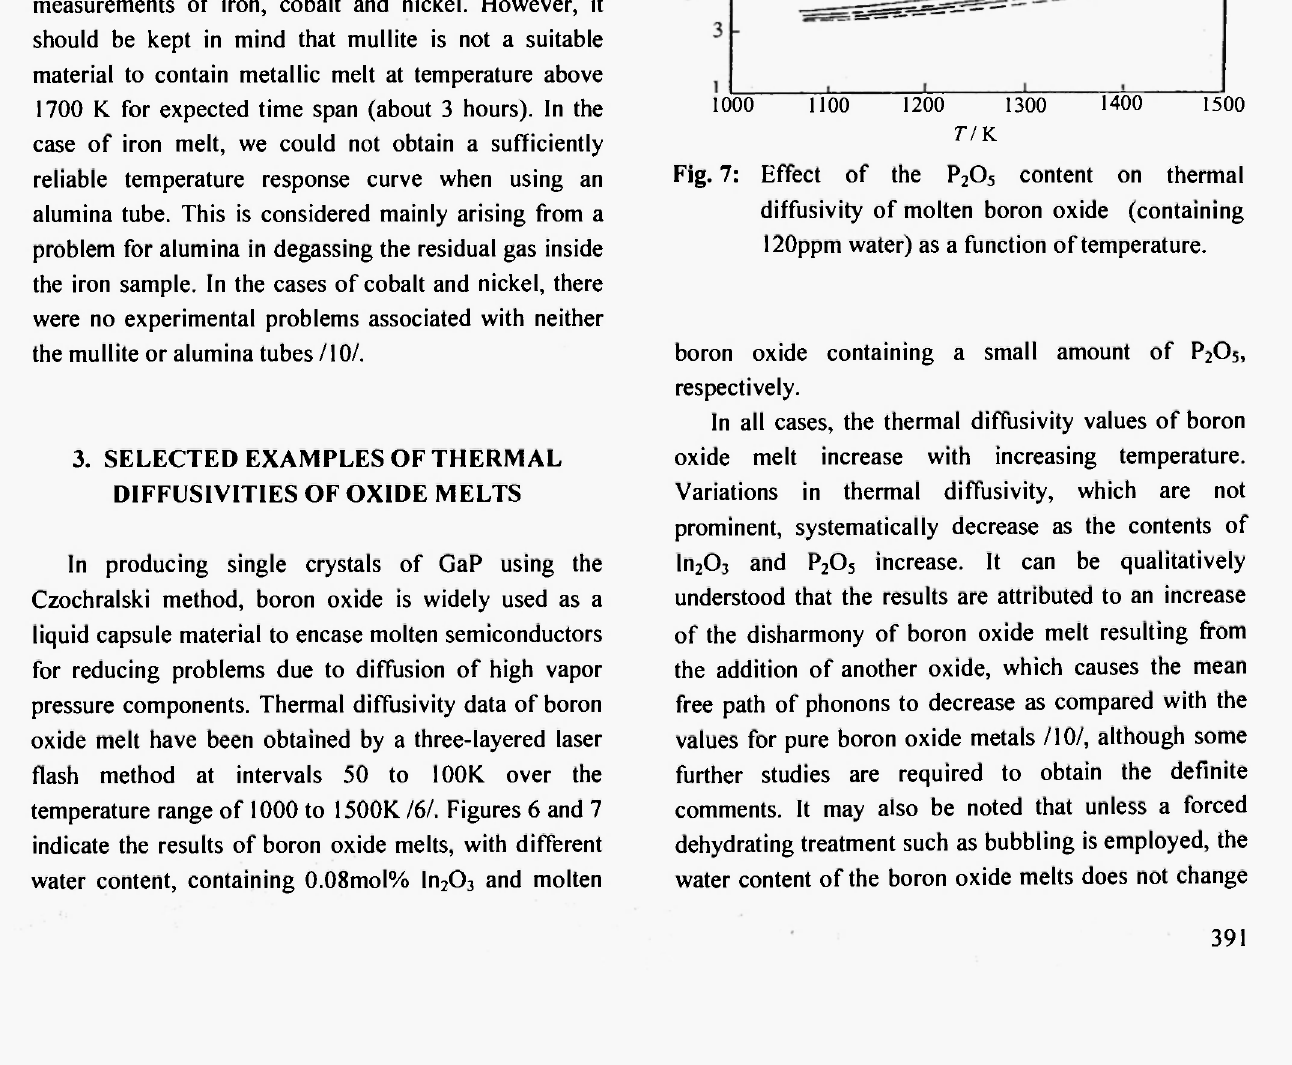
Fig. 7: Effect of the P 2 0 5 content on thermal diffusivity of molten boron oxide (containing 120ppm water) as a function of temperature.